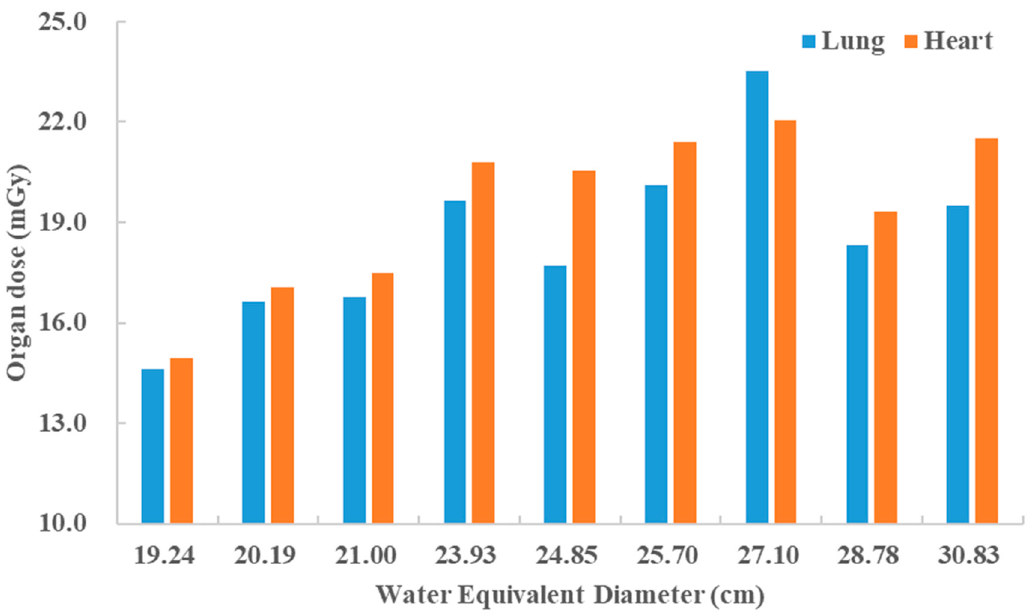
Figure 3. Organ doses simulated by Monte Carlo methods as a function of WED for male.